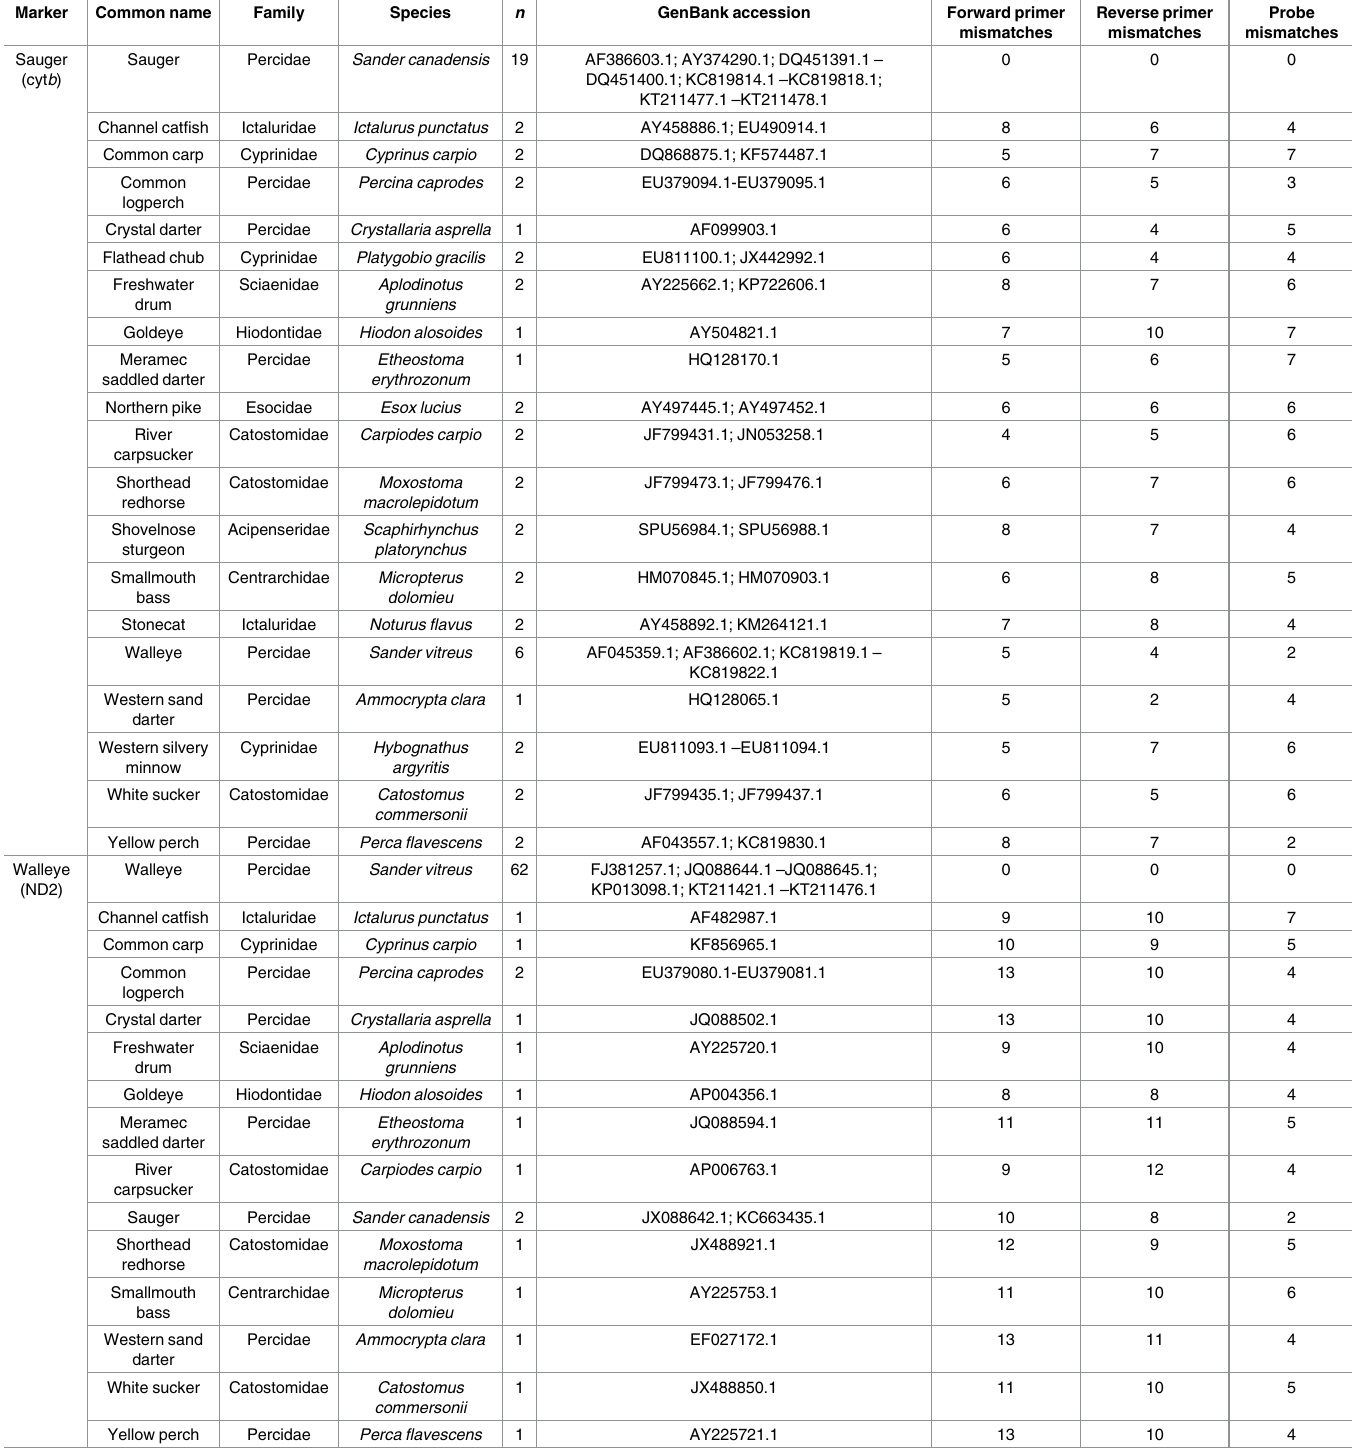
Table 1. Species, samples size ( n ), and GenBank accession number for DNA sequences used for in silico development of eDNA markersfor sau- ger and walleye. Also includedis the minimum numberof base pair mismatches betweeneach componentof markers and the sequencesscreened.